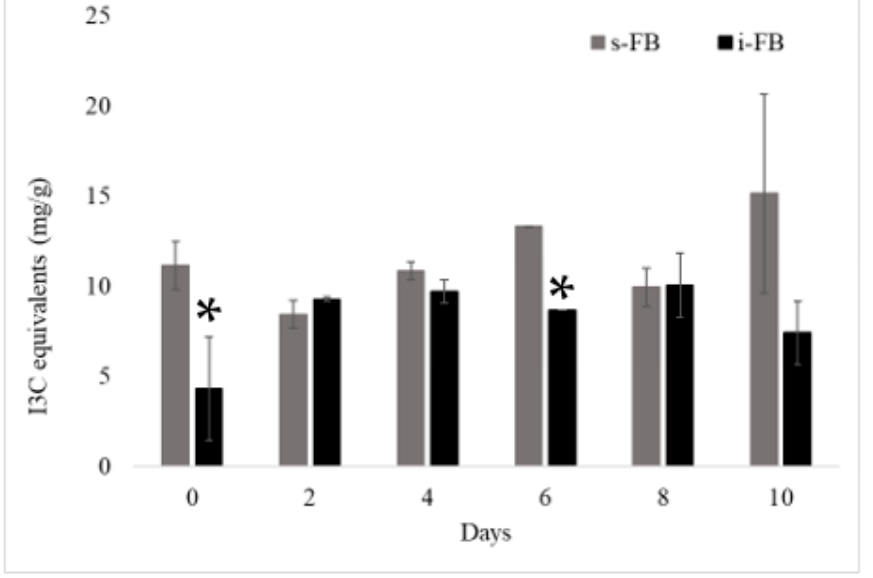
Figure 3. Quantification of sinigrin in fermented broccoli. s-FB: spontaneous fermentation; i-FB: in- duced fermentation (co-culture) *: significant difference ( p < 0.05).